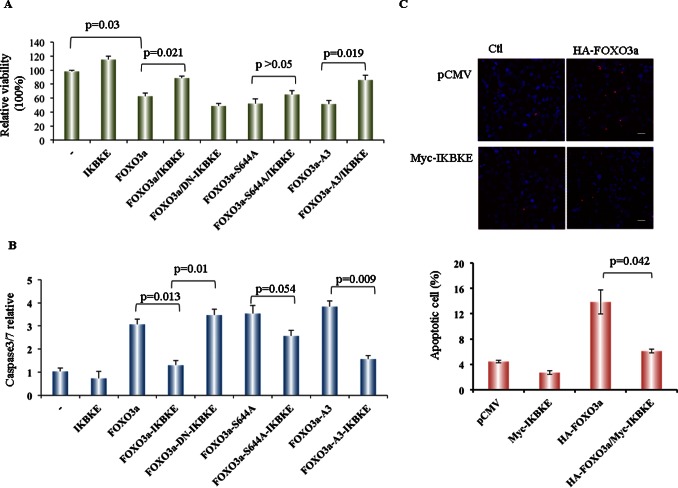
IKBKE inhibition of FOXO3a-induced cell death depends on phosphorylation of FOXO3a-S644.H1299 cells were transfected with indicated plasmids. After incubation for 48 h, cell viability (A) and caspase 3/7 activity (B) as well as TUNEL (C; scale bar is 20 µm) assays were performed as described in “Experimental Procedure”.